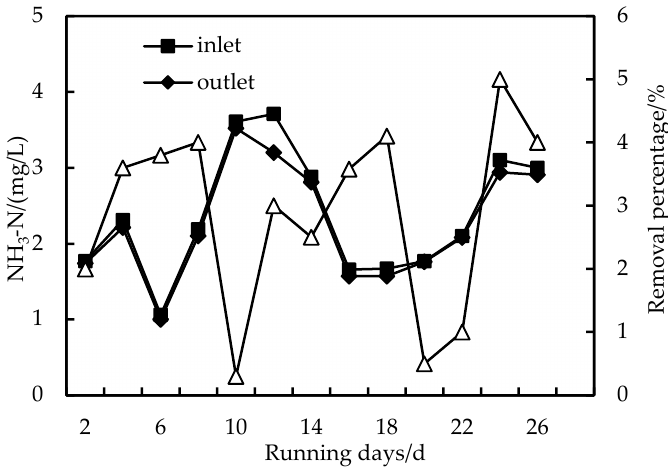
Figure 6. Removal of NH 3 -N with HUM.